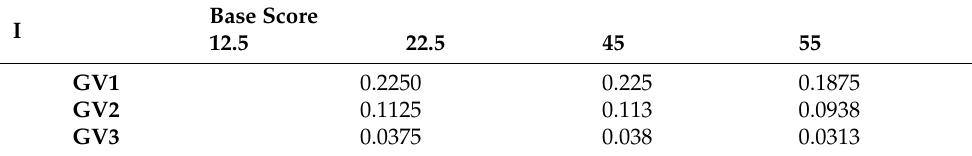
Table 5. Influence factor for GV based on the base